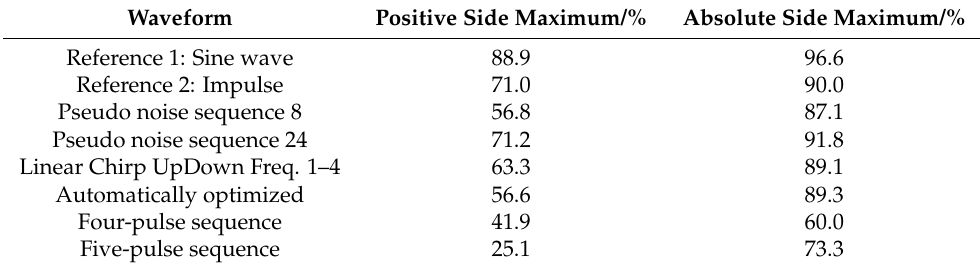
Table 3. Summary of coded sequences with the best results for the